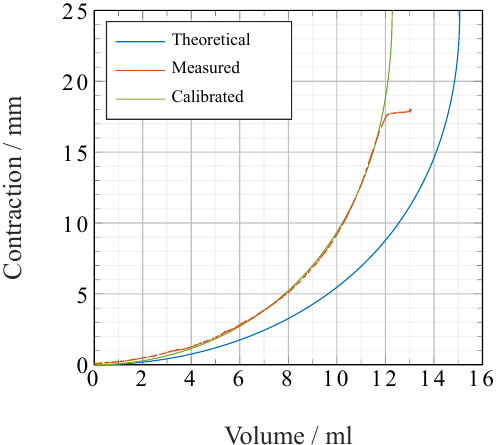
Figure 2. Theoretical, measured, and calibrated actuator contraction per unit